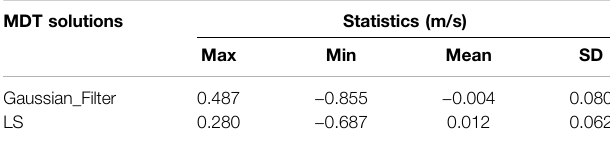
TABLE 6 | Statistics of mis fi ts between geostrophic current against the